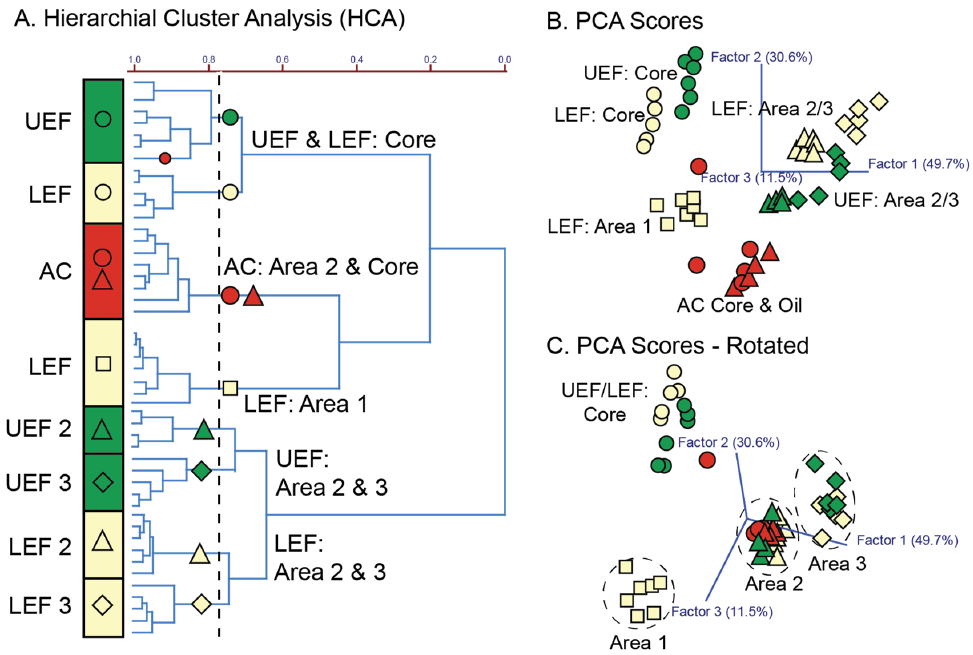
Figure 12. Statistical diagrams for the core extracts and produced oils analyzed from the three producing areas outlined in Figure 11 and color coded with respect to that figure. ( A ) Hierarchical Cluster Analysis (HCA) Dendrogram showing how the oil and extract samples across the three areas and the core group into tribes geochemically. ( B ) Principal Component Analysis (PCA) scores plots showing the distribution of all of the samples. The only core and oil samples which overlap are those from the Austin Chalk. The LEF and UEF core samples—as evident in the HCA—are geochemically offset from the equivalent producing oils in all of the production areas. ( C ) Rotated Principal Component Analysis (PCA) score plot. This plot highlights how there is a considerable geographic control on the fluid signatures, tied to lateral organofacies variation.